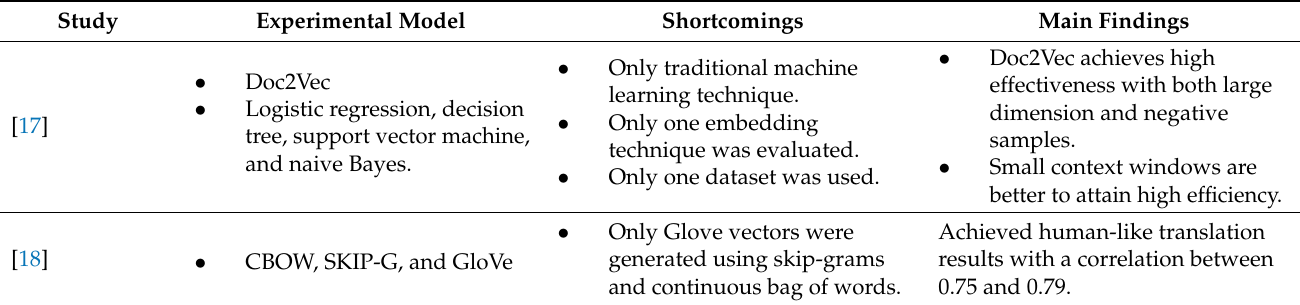
Table 1. Summarization of related